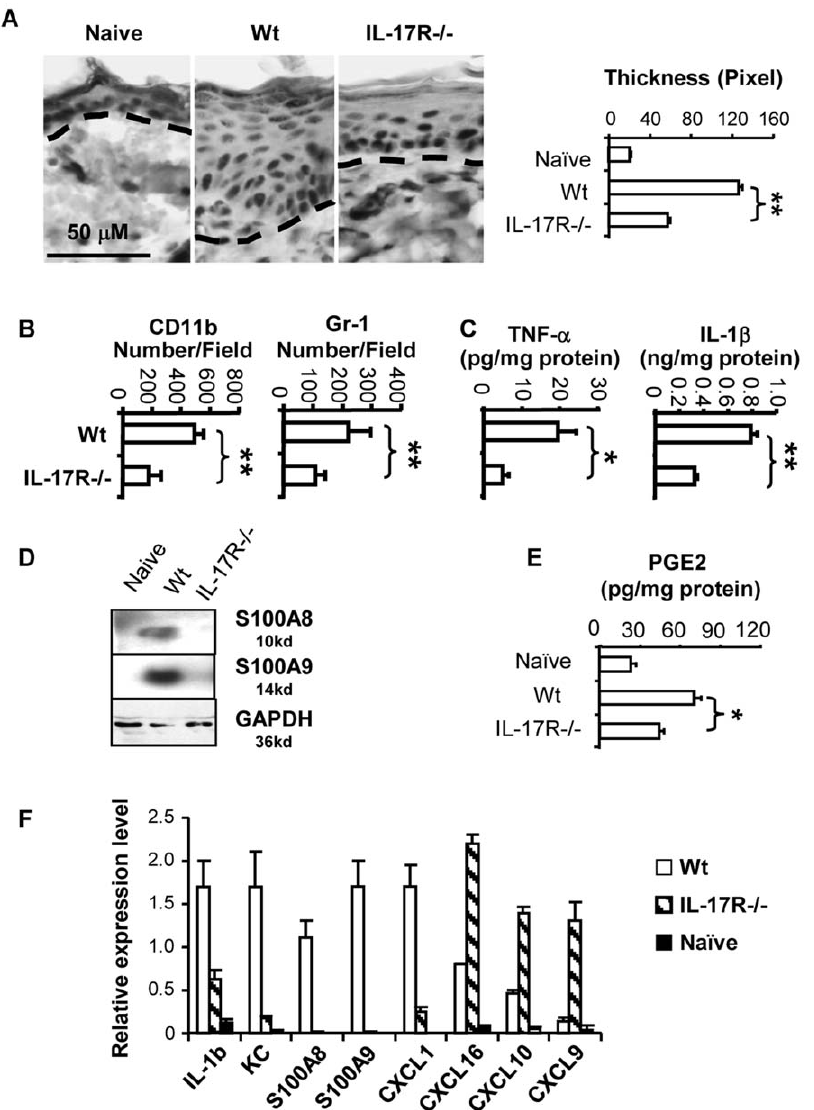
Figure 3. The deficiency in IL-17 receptor inhibits TPA induced tumor promoting inflammation in the skin. Mice were treated topically with TPA every other day for a total of three applications. Skin tissues were harvested 24 hours after the last treatment. A). Paraffin embedded tissue sections were stained with hematoxylin. Skin samples from naı¨ve untreated mice served as controls. Dashed lines indicate the border between the epidermis and dermis. The thickness of epidermis was measured microscopically (n=10). B). Frozen tissue sections were stained immunohistochemcially with antibodies. CD11b + (monocytes/macrophages) and Gr-1 + (granulocytes) cells were counted microscopically (n=6). C) Concentrations of cytokines in the skin lysates were measured by ELISA (n=4). D). S100A8 and S100A9 proteins in the skin lysates were detected by Western blots using specific antibodies. E). Concentrations of PGE2 in the skin lysates were measured by a PGE2 EIA kit (n=3). F). Expression levels of mRNA for chemokines and cytokines in the skin lysates were quantified by real time RT-PCR (n=3). Data are representative of 2–3 independent experiments (mean + / 2 SEM, * P , 0.05: ** P , 0.01).